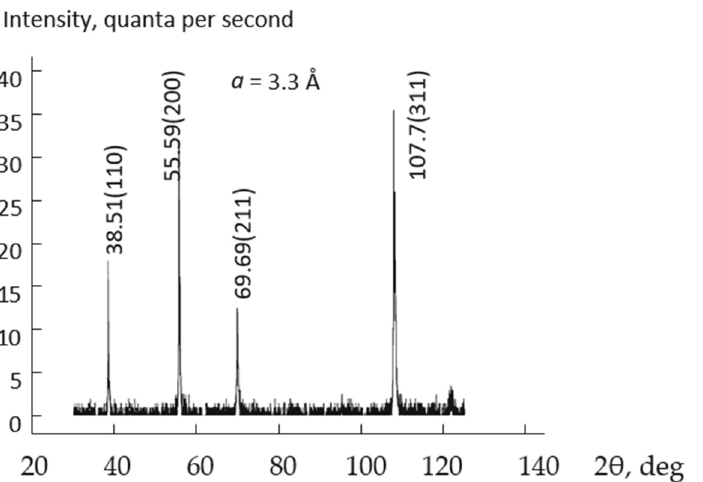
Figure 3. X-ray diffraction pattern for polished polycrystalline tantalum with indication of X-ray scattering angles 2 θ -grad and Miller indices ( hkl ) of crystallographic planes above each diffraction peak [18].